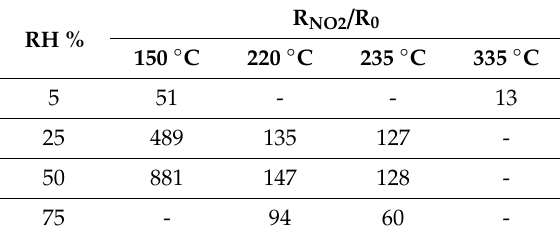
Table 3. R NO2 / R 0 responses of a-SnO 2 sensor to 12 ppm NO 2 at various temperatures and for di ff erent relative humidity